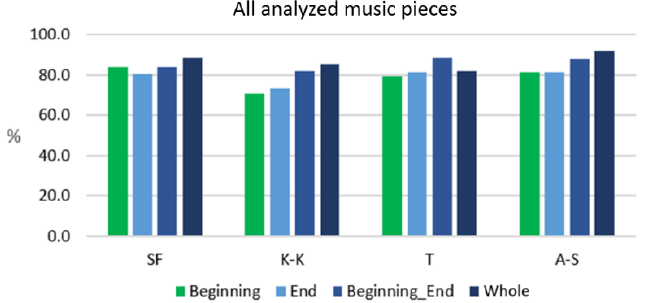
Figure 14. The key-finding efficacies obtained for various sample selection options, regardless of the type of the analyzed sample’s pitch-class representation (results for all the considered music pieces).